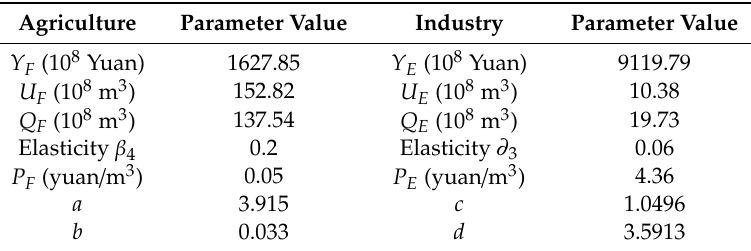
Table 2. Data and elasticity inputs to the